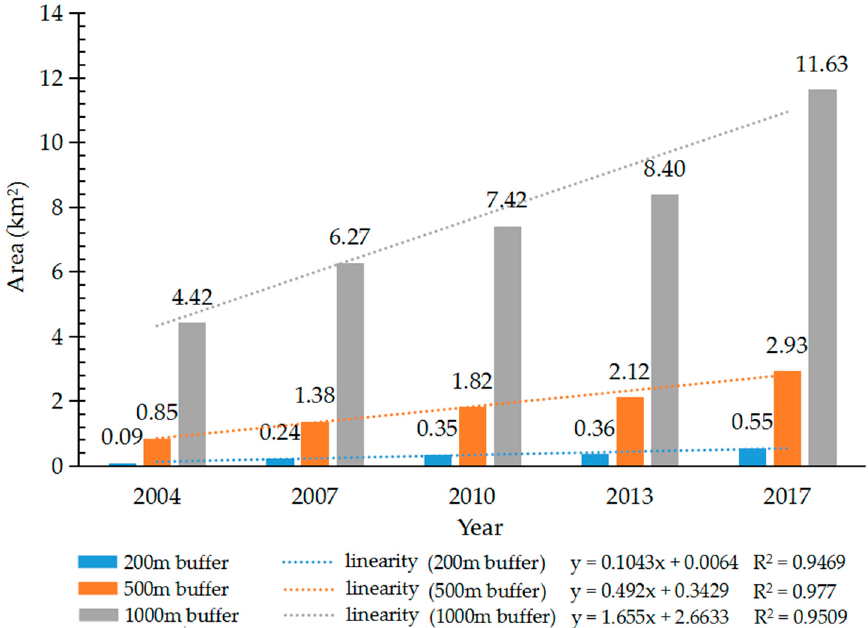
Figure 12. The area of urban expansion in buffer zones from 2004 to 2017.